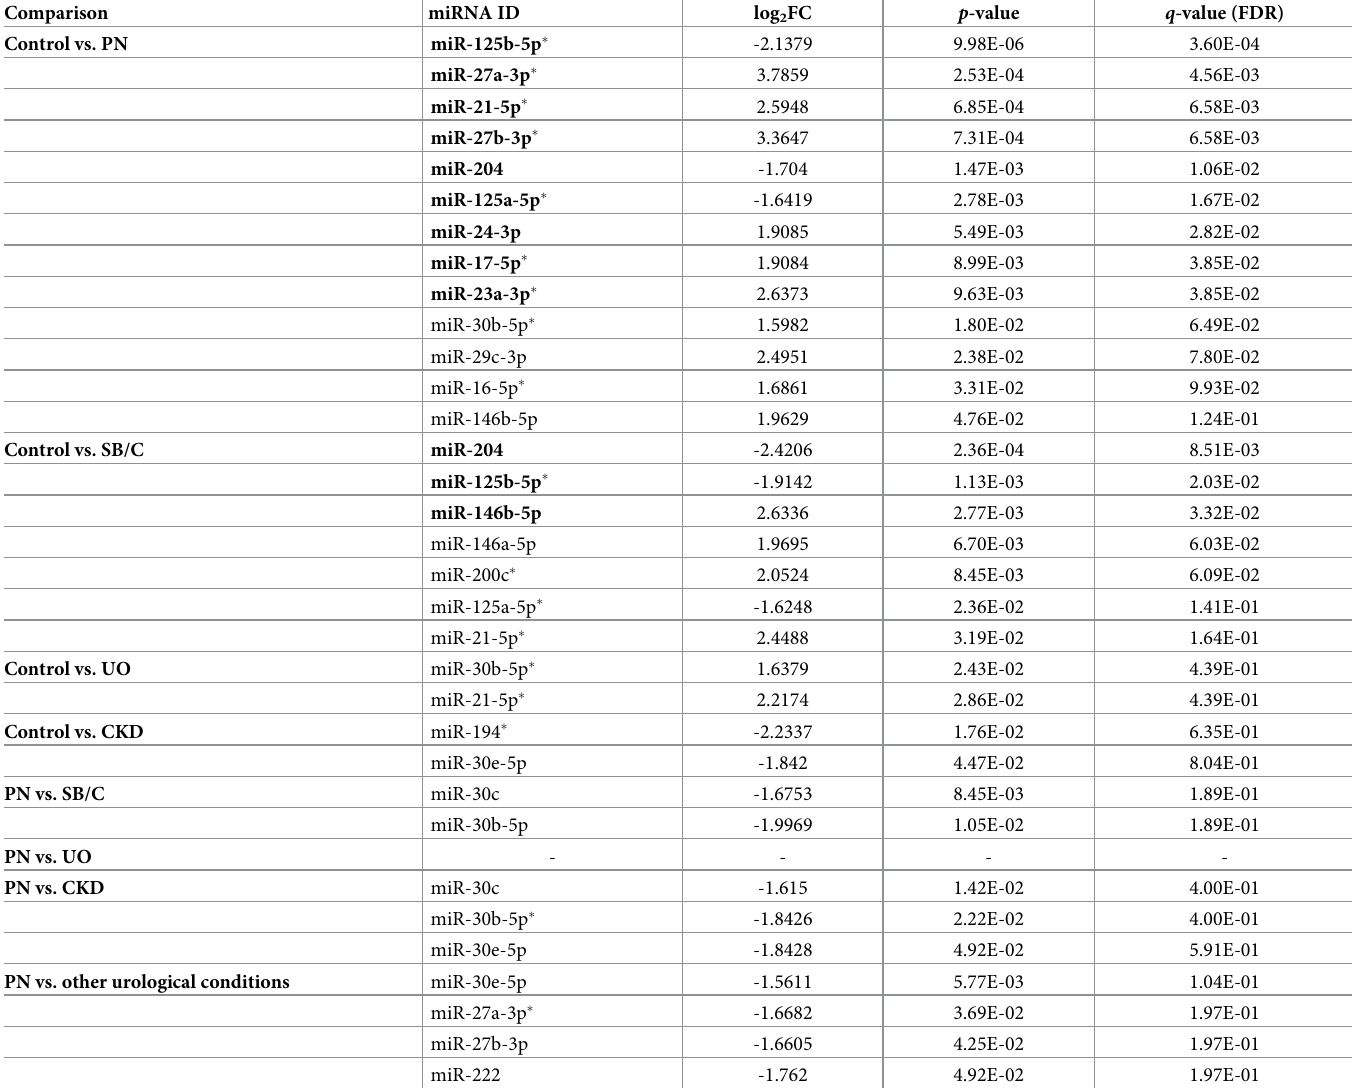
Table 3. Differentially abundant (DA) miRNAs from qPCR